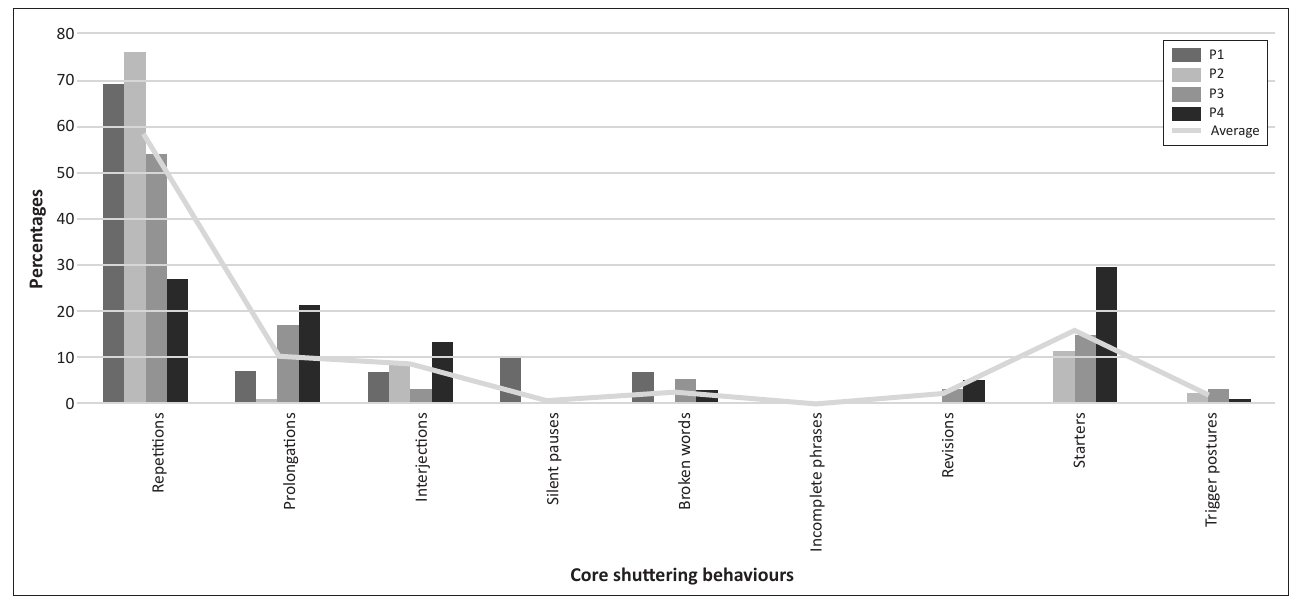
FIGURE 1: Predominant core stuttering behaviours presented by P1 –